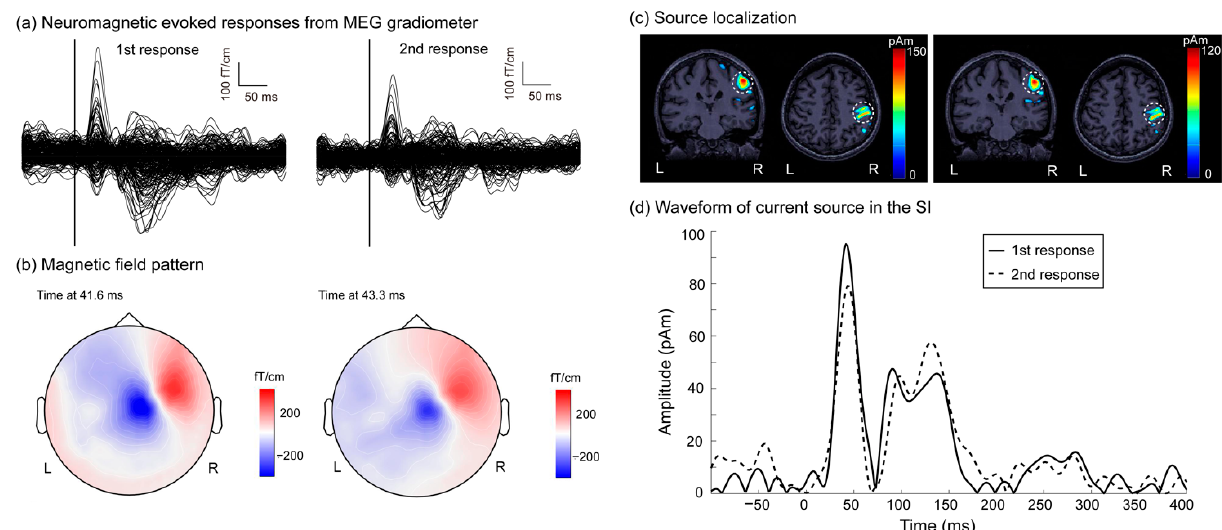
Figure 1. ( a ) Neuromagnetic evoked responses in response to paired stimulation across 204-MEG gradiometer sensors (left, first response; right, second response) in one patient with EMs (EM #1) at − 100 to 400 ms. ( b ) Magnetic field patterns of peak latency in the first and second responses at 41.6 and 43.3 ms, respectively. ( c ) Mapping of the source localization of peak latency in the first and second responses onto the individual’s magnetic resonance images. Amplitudes of the cortical sources (color-coded). ( d ) Time-varying amplitude responses in the primary somatosensory area in the first and second responses are shown at − 100–400 ms. SI, primary somatosensory cortex.